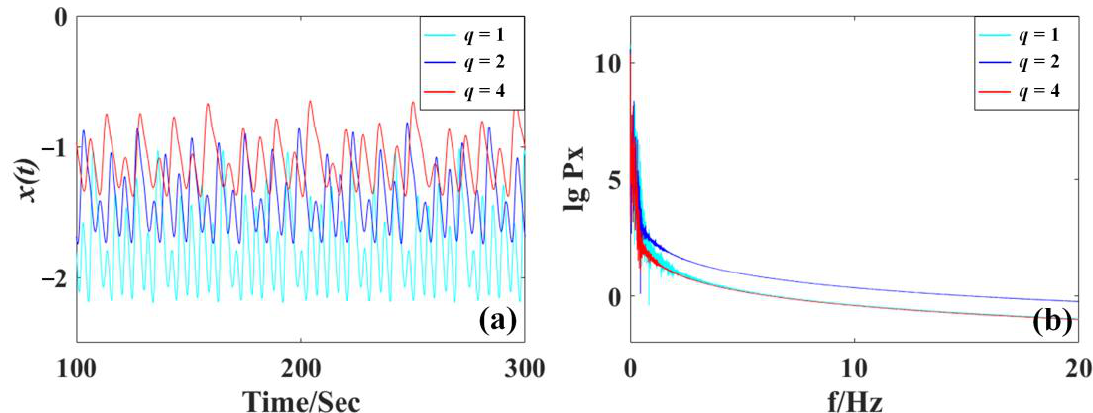
Figure 3. Waveform and frequency spectra of x from the system (7) with a = 0.5, b = 0.6, c = 1.2 and